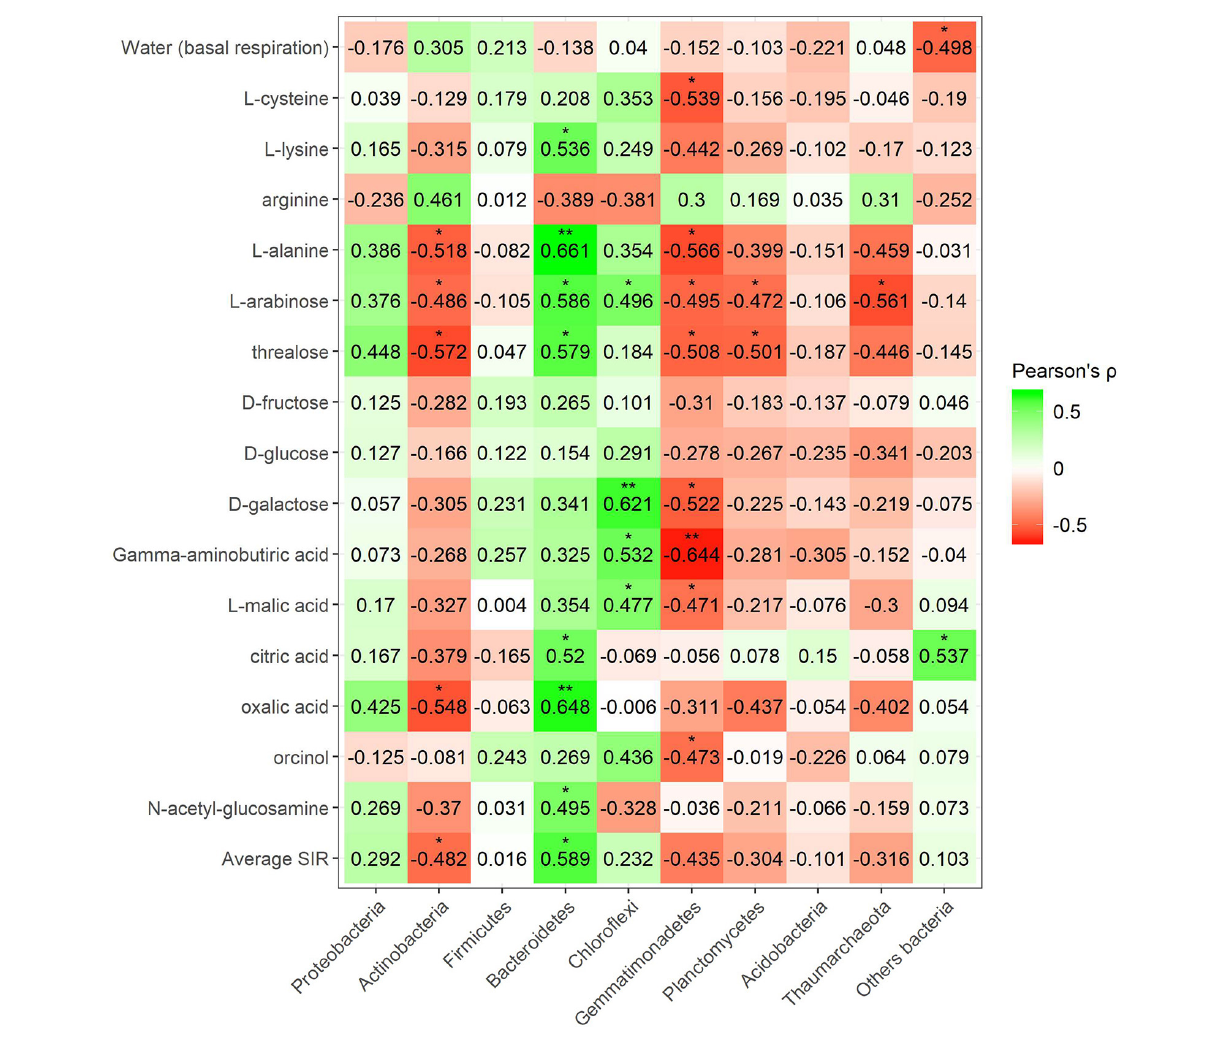
FIGURE 6 | Heatmap of Pearson’s correlation coefficient ( r ) between the most abundant bacterial phyla (plant–soil effect) and the SIR results of the different carbon sources. Heatmap colors represent the Pearson correlations ranges, from red (negative correlation), passing through white (no correlation) to green (positive correlation). Significant results are indicated by an